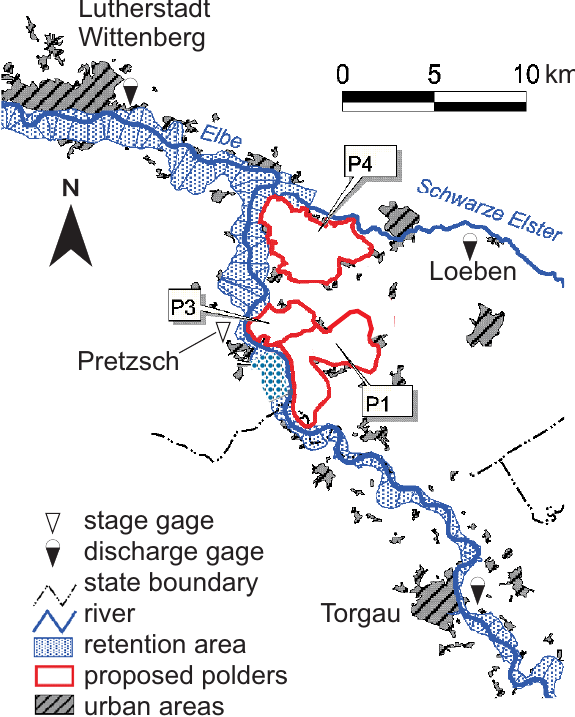
Fig. 2. Variants of polders that have been proposed to be constructed along the middle reach of the Elbe River in Germany between Tor- gau and Lutherstadt Wittenberg (source: IWK,